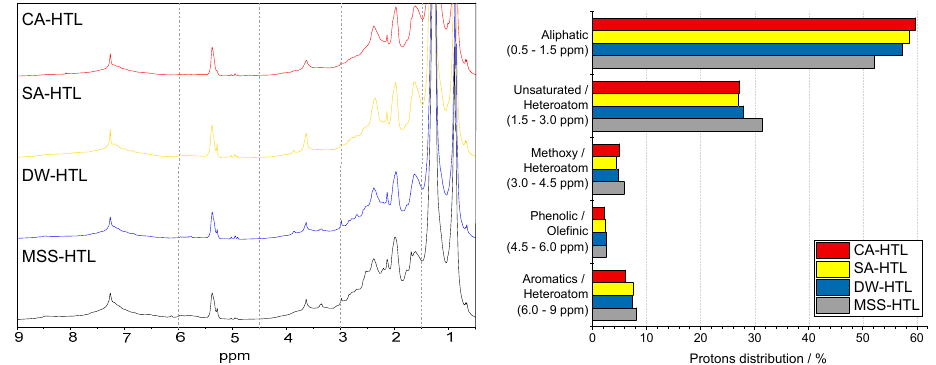
Figure 8. 1 H NMR spectra and spectral distribution of functional groups present in biocrude based on integrated peak areas assigned to characteristic spectral regions.